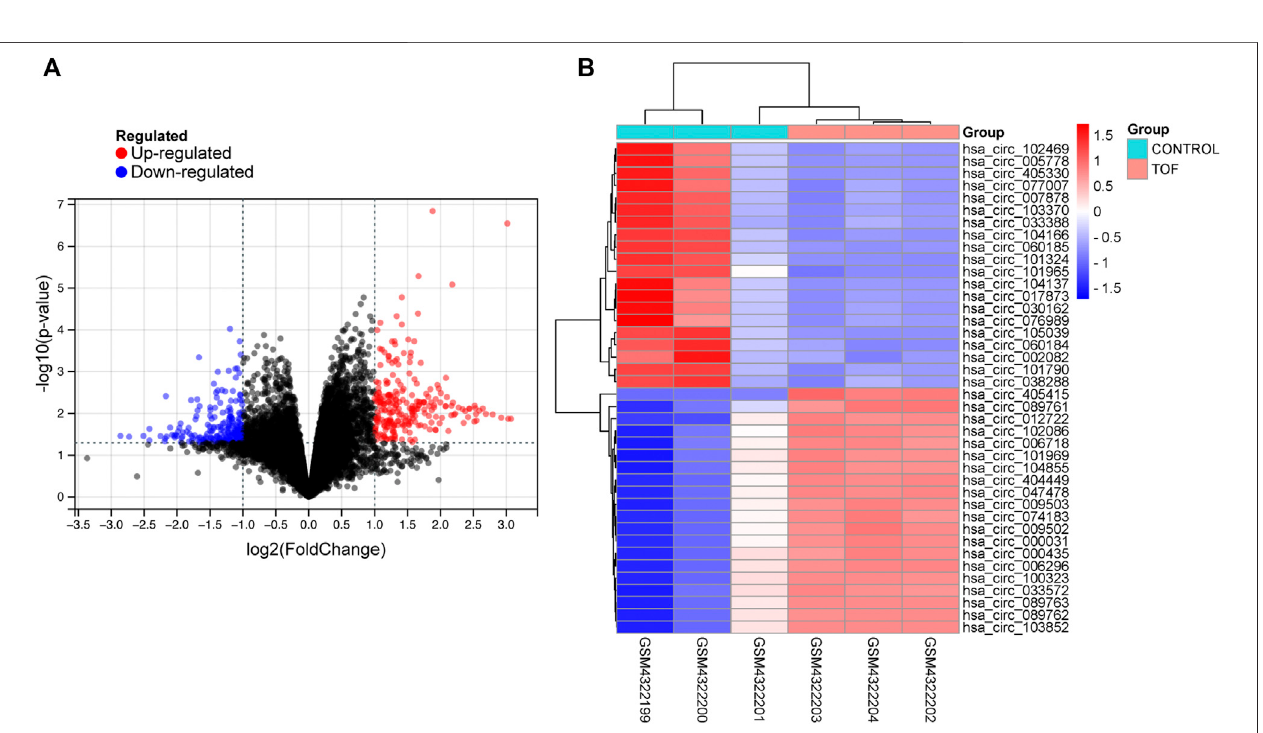
Frontiers in Genetics |